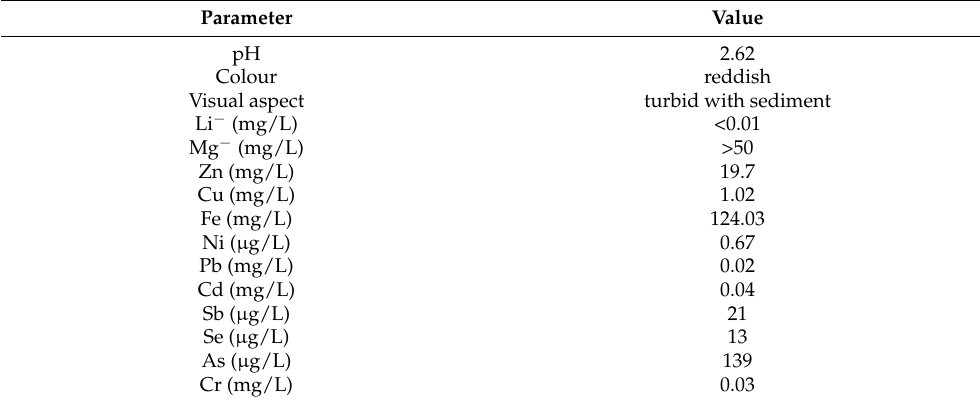
Table 4. Chemical characterization of Rosia Montana drainage water.